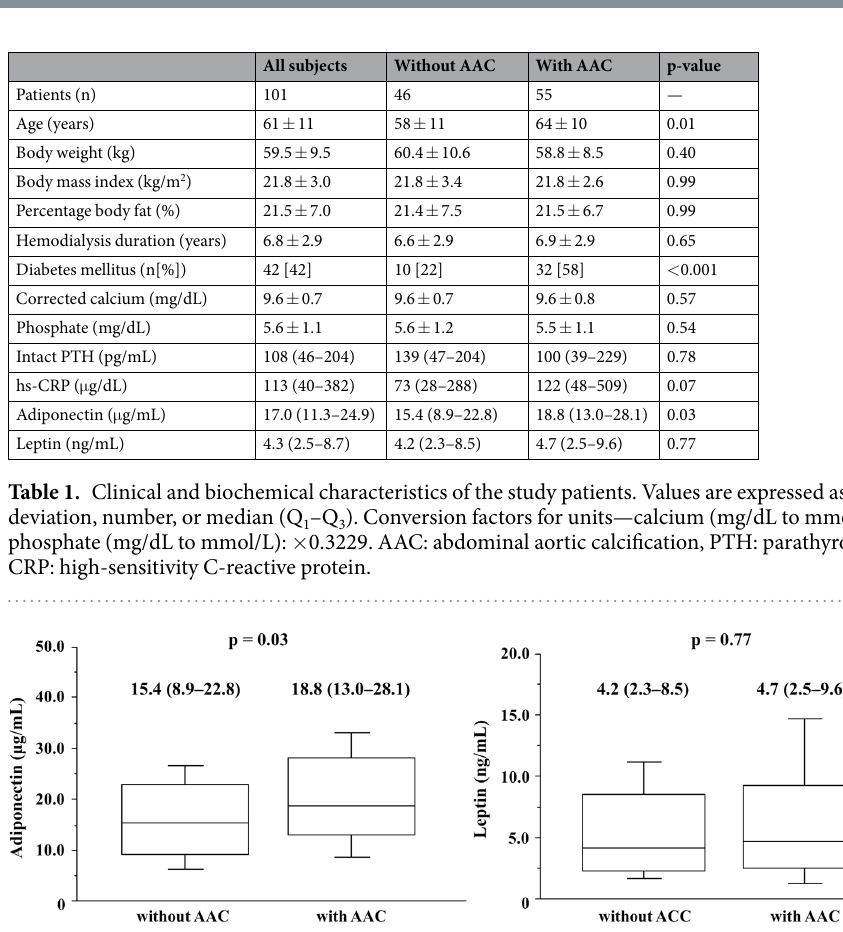
Figure 1. Relationship between abdominal aortic calcification (AAC) and serum adiponectin or leptin levels Serum adiponectin levels are significantly higher in patients with AAC than in those without (18.8 [13.0–28.1] µ g/mL, n = 55 vs . 15.4 [8.9–22.8] µ g/mL, n = 46; p = 0.03), whereas serum leptin levels are not significantly different between the two groups (4.7[2.5–9.6] ng/mL, n = 55 vs . 4.2 [2.3–8.5] ng/mL, n = 46; p =